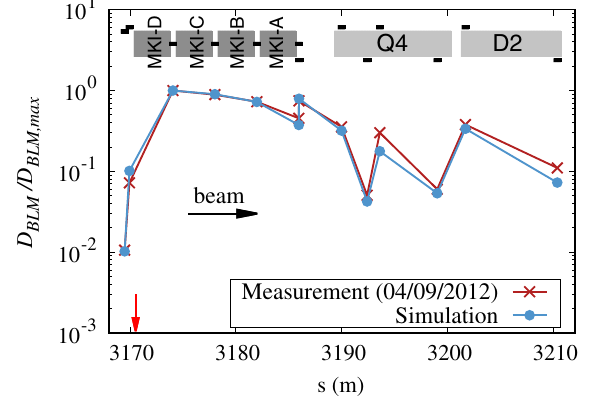
FIG. 13. Comparison of simulated and measured BLM signal patterns for a dust-particle-induced loss event in the LHC injection kickers in IR2. All patterns are expressed as a fraction of the maximum signal. The beam direction is from the left to the right. The event occurred during a fill with 4 TeV protons in 2012. The vertical arrow indicates the dust particle position assumed in the simulation. The statistical error of the simulation results is less than 10%, except for the two BLMs upstream of the assumed dust particle